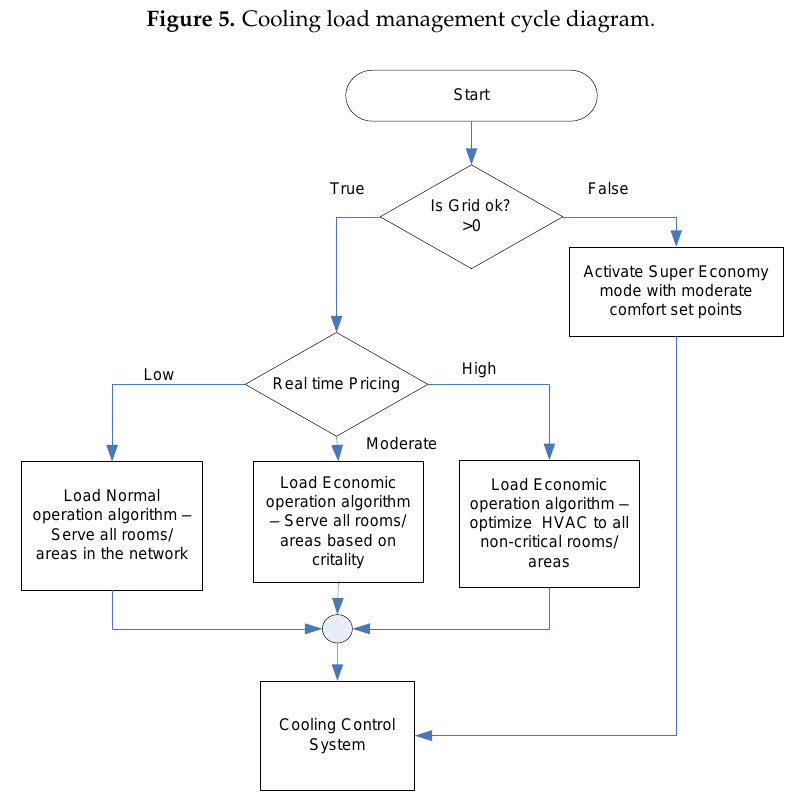
Figure 6. Cooling system control flow chart.